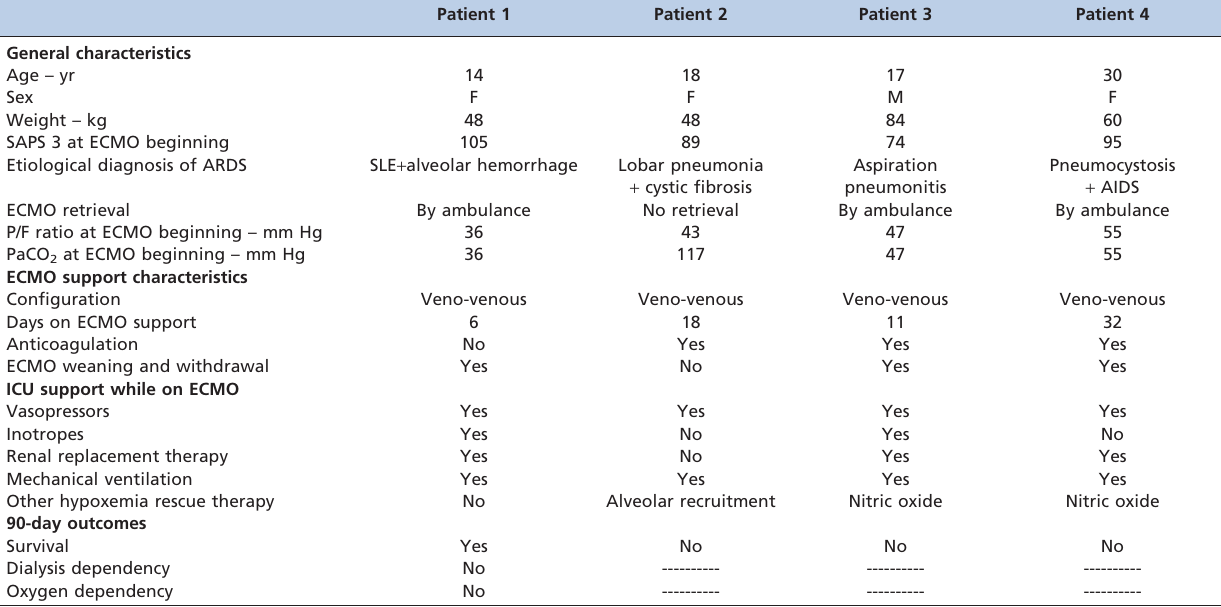
Table 1 - Characteristics of